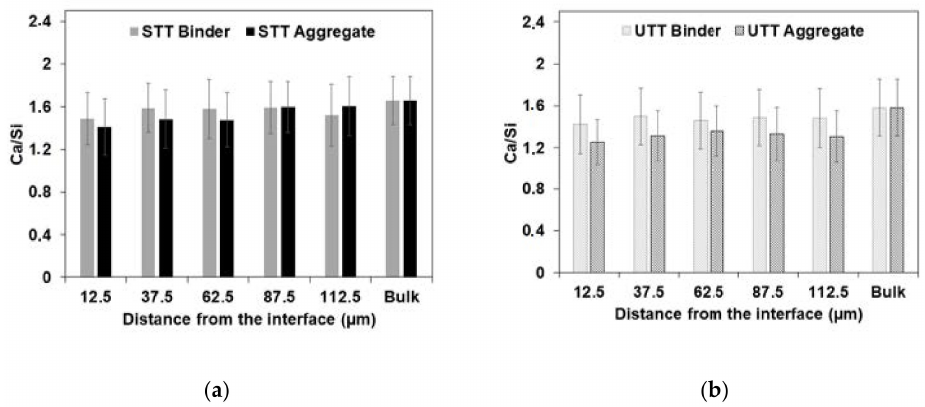
Figure 17. Ca / Si atomic ratio at various distances from binder-UHPC to aggregate-UHPC interfaces of columns using ( a ) shuttering plywood (STT); ( b ) untreated plywood (UTT) formwork.